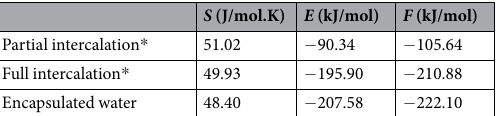
Table 1. Thermodynamic properties (entropy S , total energy E and free energy F ) at 300 K calculated for each water molecule under different confinements. * For full intercalated water monolayer between graphene sheets, additional constraints come from the periodic boundary conditions applied in the lateral dimensions. Models are constructed with an interlayer distance of 0.64